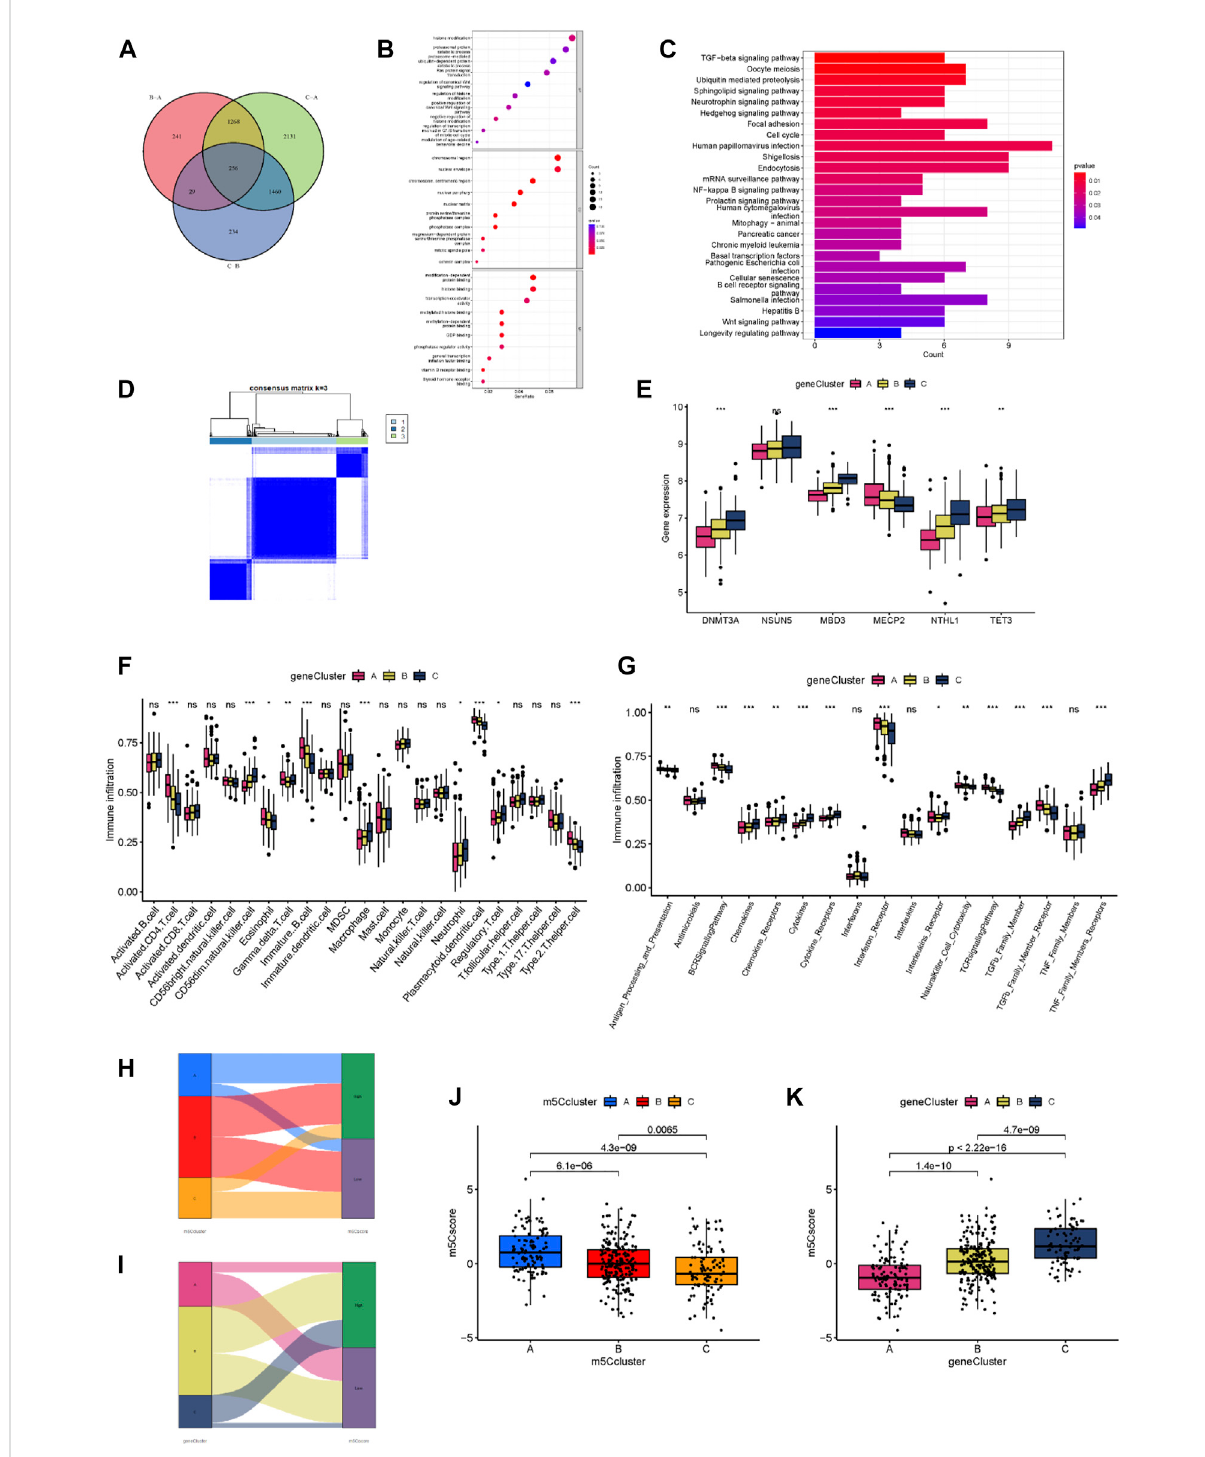
FIGURE 7 Development of the m 5 C score and its biological functions. (A) Venn diagram showing 256 m 5 C-related DEGs for the three clusters. (B) GO enrichment analysis of m 5 C-related DEGs. (C) KEGG enrichment analysis of m 5 C-related DEGs. (D) The consensus matrix heatmap de fi ned three m 5 C gene clusters. (E) Expression levels of the m 5 C regulators for each of the three m 5 C gene clusters. (F) Abundance of in fi ltrating immune cells in each of the three gene clusters. (G) Differences in the activity of 17 immune response reactions among the three gene clusters. (H) A Sankey diagram of the different m 5 C modi fi cation clusters and m 5 C scores. (I) A Sankey diagram of the different m 5 C gene clusters and m 5 C scores. (J) Differences in the m 5 C scores among the three m 5 C modi fi cation clusters ( p < 0.001). (K) Differences in the m 5 C scores among the three m 5 C gene clusters ( p < 0.001). * p < 0.05; ** p < 0.01; *** p <